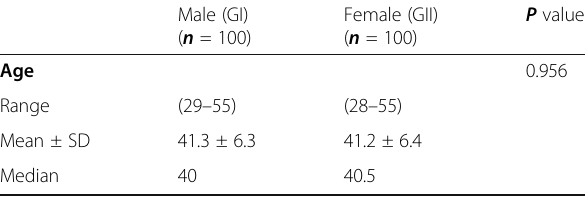
Table 1 Comparison between male and female teachers in